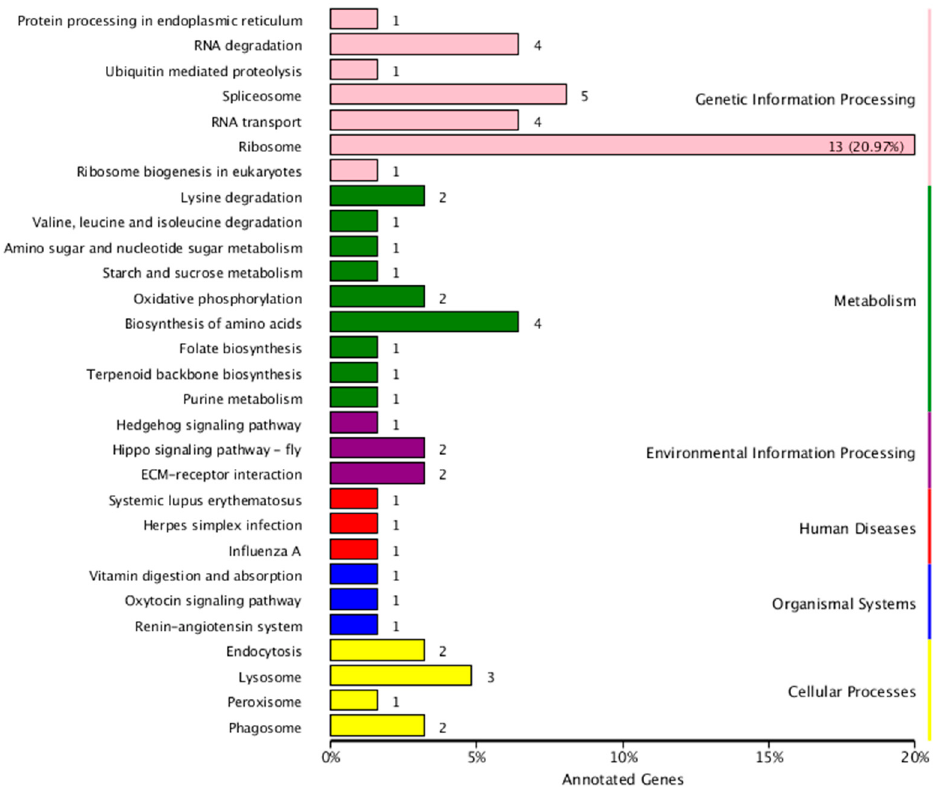
Figure 9. KEGG analysis of miRNA targets in RKN.